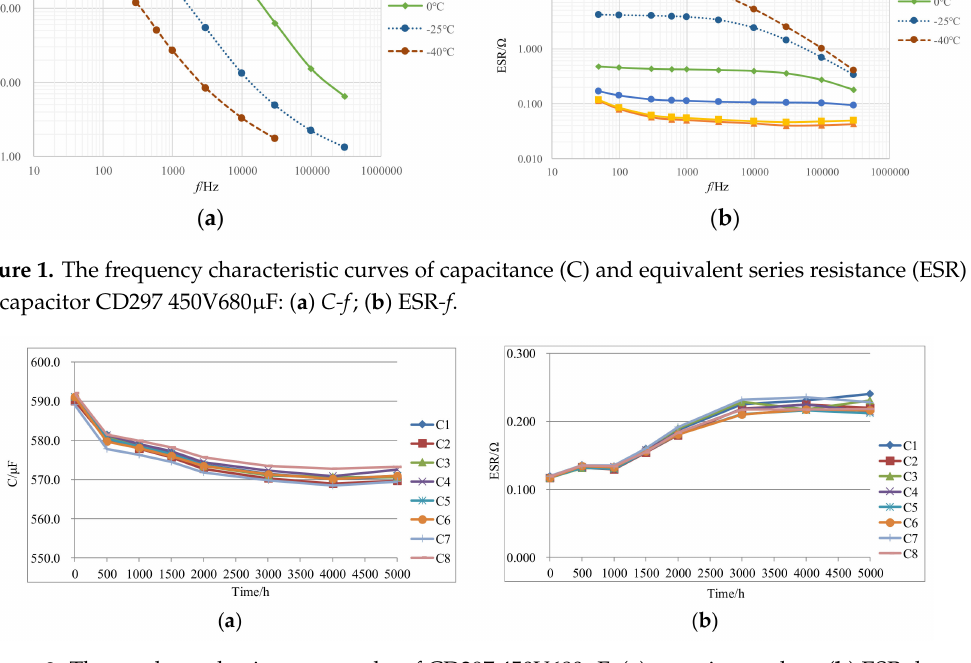
Figure 2. The accelerated aging test results of CD297 450V680 µ F: ( a ) capacitance data; ( b ) ESR data.